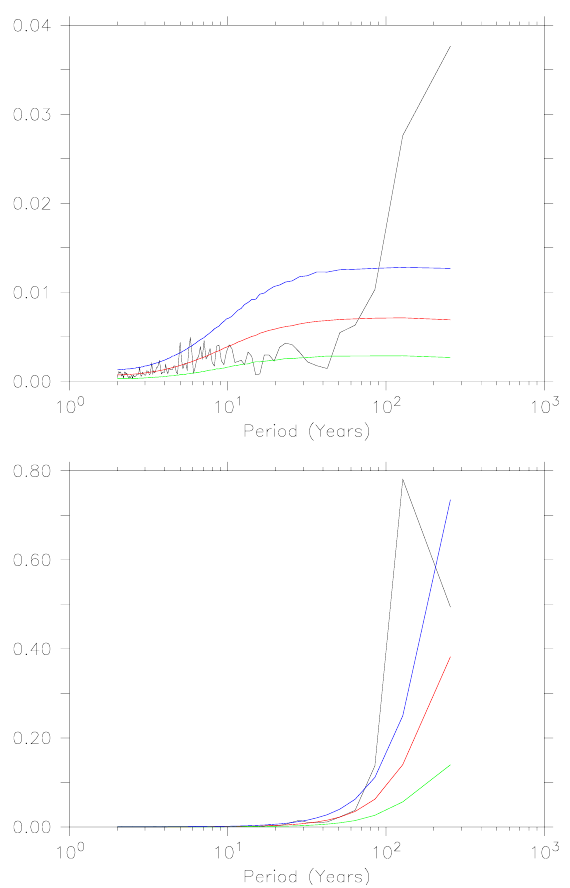
Fig. 17. The power spectra of the Arctic (top) and Antarctic (bot- tom) sea ice volume in 10 24 m 6 in the control run. The simulated AR(1) spectrum (red), and the minimum (green) and maximum (blue) of the 95% confidence interval are also shown.